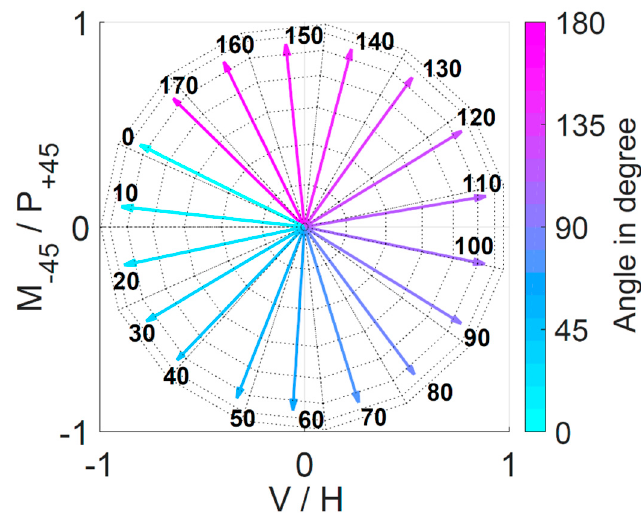
Figure 7. Stokes vector of the fast axis of retardation for different sample orientation. The vectors are averaged over the given sample size of three and each angle was measured twice as the sample was rotated by 370°.